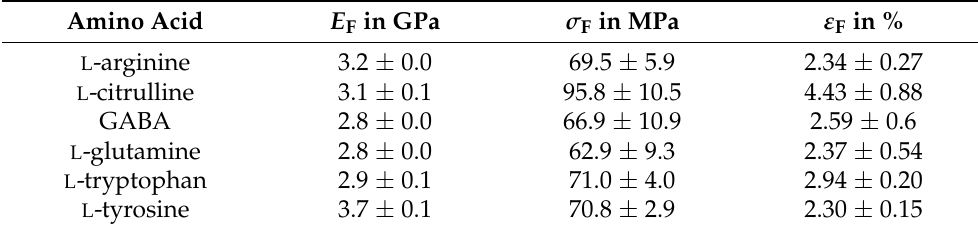
Table 4. Flexural modulus E F , flexural strength σ F , and fracture strain ε F of amino-epoxides (average ± standard deviation).